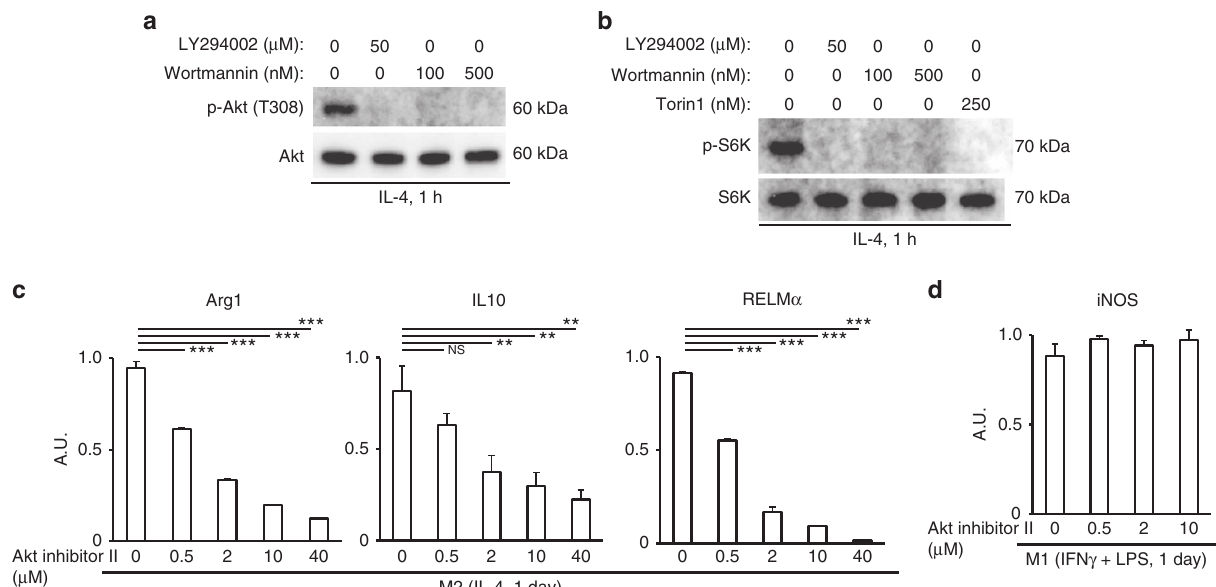
Figure 4 | PI3K and Akt are the upstream signal pathway responsible for mTORC1 activation by IL-4. ( a ) Western blot for Akt phosphorylation in wild-type BMDMs stimulated for 1h with IL-4. Inhibitors for PI3K were added 10min before IL-4 stimulation, and also existed during IL-4 stimulation. ( b ) Western blot for mTORC1 activity in wild-type BMDMs. Macrophages were stimulated for 1h with IL-4. Each inhibitor for PI3K or mTOR was added 10min before IL-4 stimulation, and also existed during IL-4 stimulation. ( c , d ) Real-time PCR for M2 ( c ) and M1 ( d ) signature genes expressed in wild-type BMDMs polarized with each stimulants with concomitant Akt inhibition. Polarizing conditions in detail are described in Method section. The representative results of two independent experiments are shown for each panel. ** P o 0.01, *** P o 0.001. Error bars show